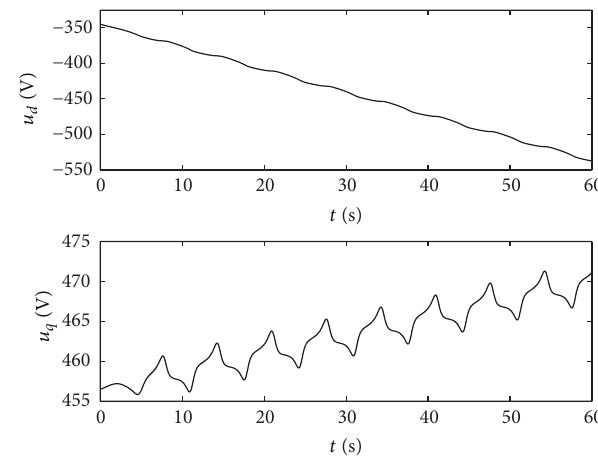
Figure 2: System control